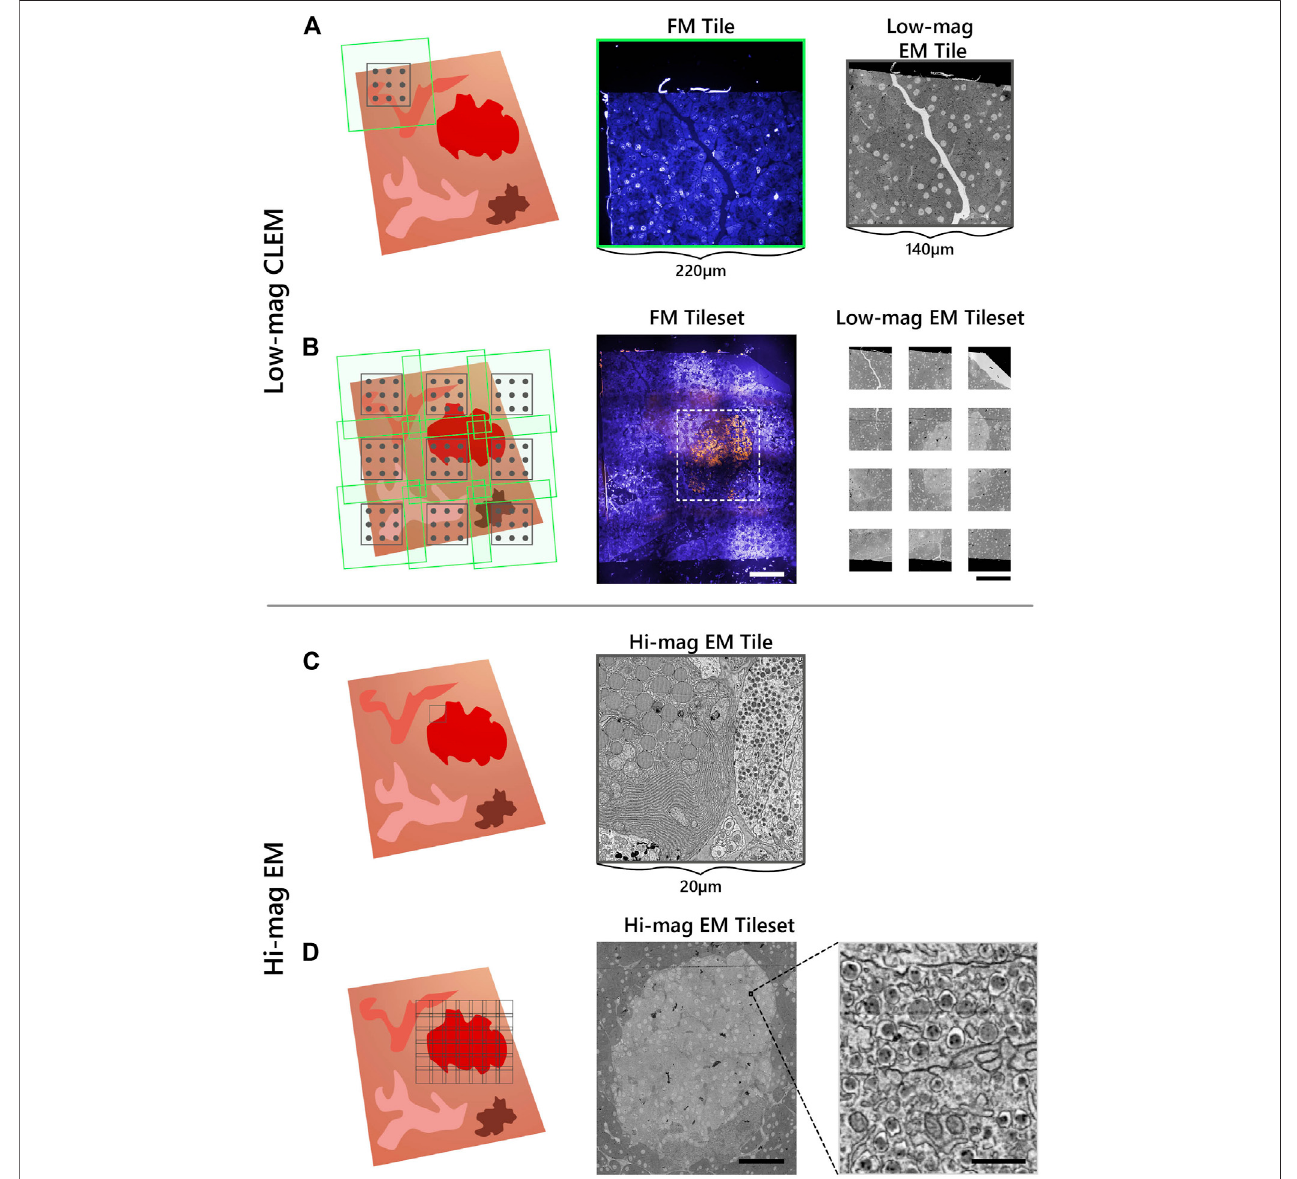
FIGURE 2 | Integrated array tomography provides ef fi cient, high-precision EM-FM imaging without bleaching of the fl uorescence. (A) Acquisition of correlative FM (green outline) and low-magni fi cation EM (black outline) images, followed by a registration procedure involving CL spots (grey circles) to register the image pair. (B) The stage is translated in a grid-like fashion such that there is suf fi cient overlap between neighboring FM image tiles — leaving a gap between adjacent EM tiles. (C) The fl uorescencesignalisusedtoidentifytargetsforsubsequentEMimaging(blackoutline). (D) ThetargetROIiscapturedbyanautomatedtilesetofhighmagni fi